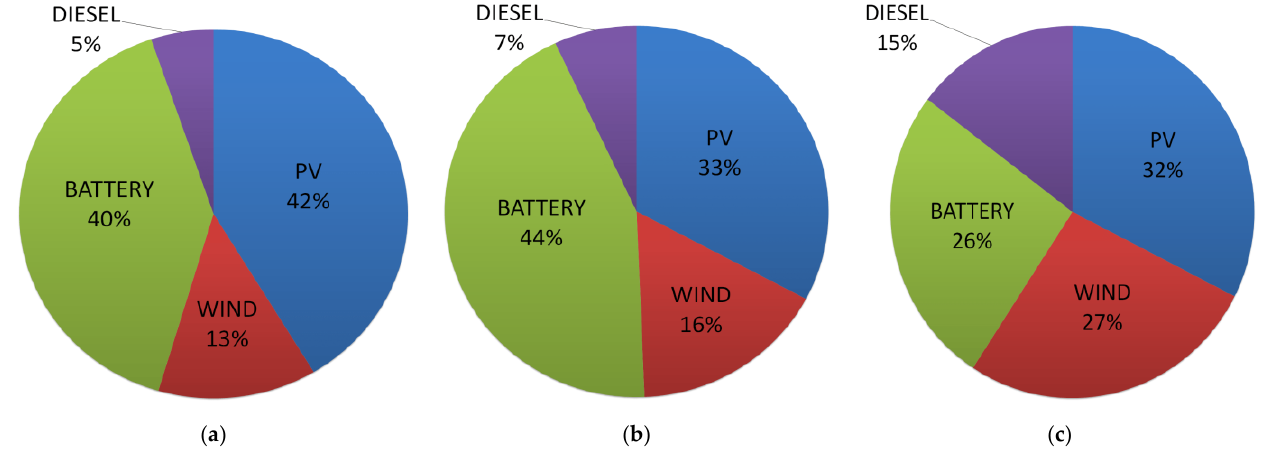
Figure 13. The annual contribution of energy generation by PV/WT/battery and DG for MOSSA. ( a ) Solution #1; ( b ) solution #10; ( c ) solution #20.